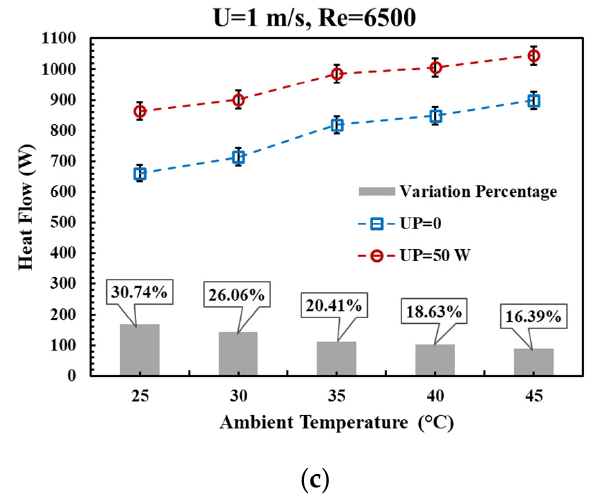
Figure 9. The variations of heat flow against ambient temperature at 𝑈 = 1 (m/s) and Reynolds numbers of ( a ) Re = 2166, ( b ) Re = 4333, and ( c ) Re = 6500. The results are presented in a no-vibration state (UP = 0) and in the presence of vibration with ultrasonic power of 50 Watts (UP = 50 (W)).